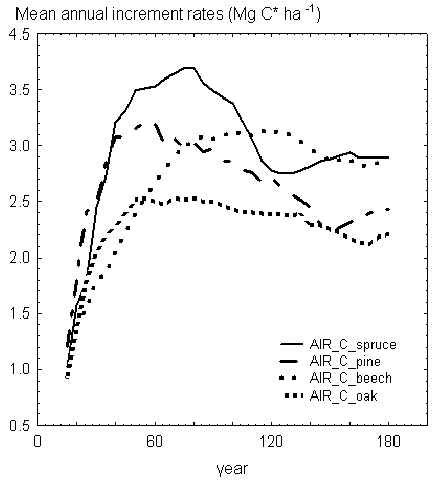
Figure 6. Mean annual increment rates (AIR) (Mg C ha − 1 ) for spruce, pine, beech and oak in the managed